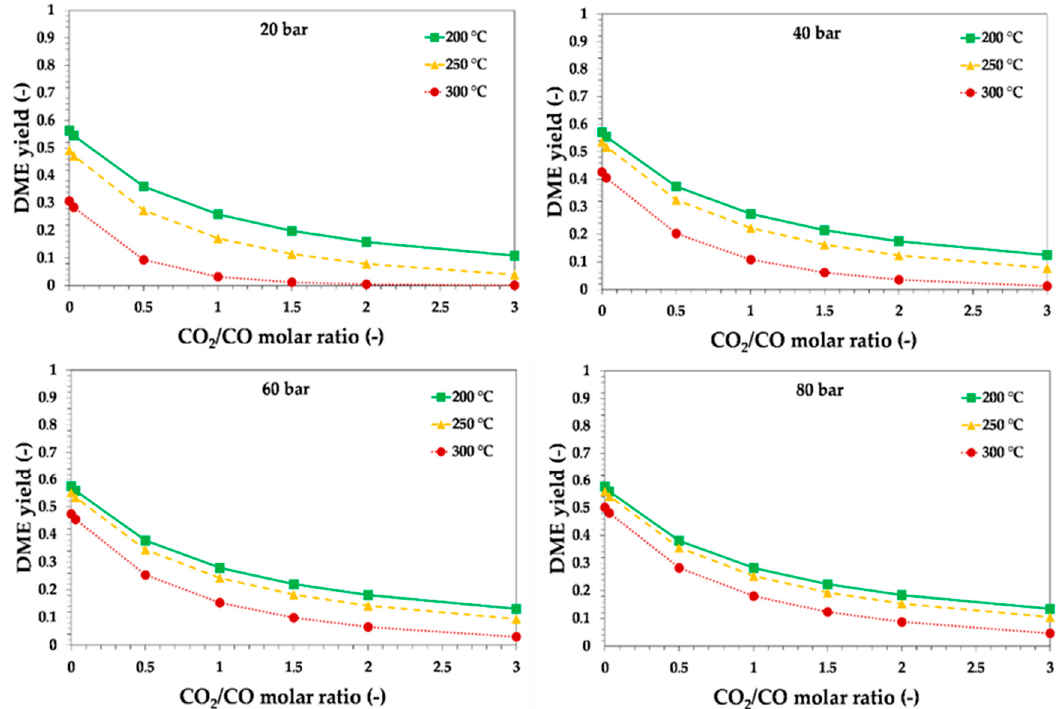
Figure 5. Theoretical equilibrium DME yield as a function of the initial CO 2 /CO molar ratio, reaction temperature and pressure, for syngas with H 2 /CO = 0.87. Lines are only a guide for the reader.